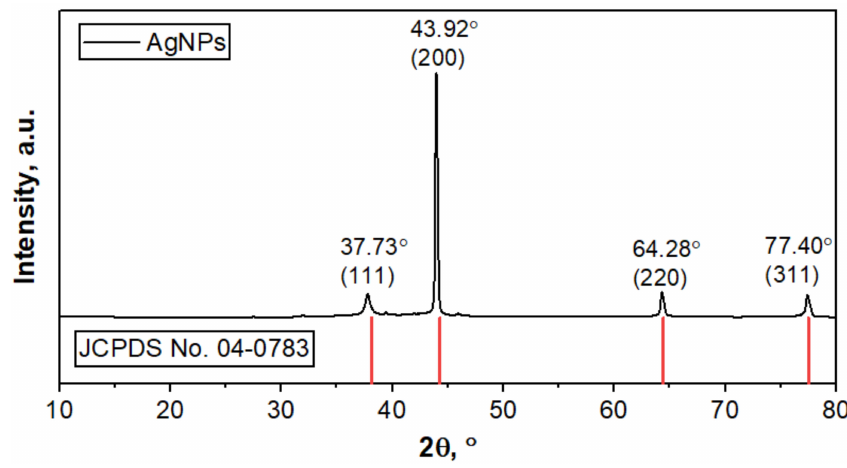
Figure 3. XRD spectra analysis of c-AgNPs and silver (JCPDS No. 04-0783).